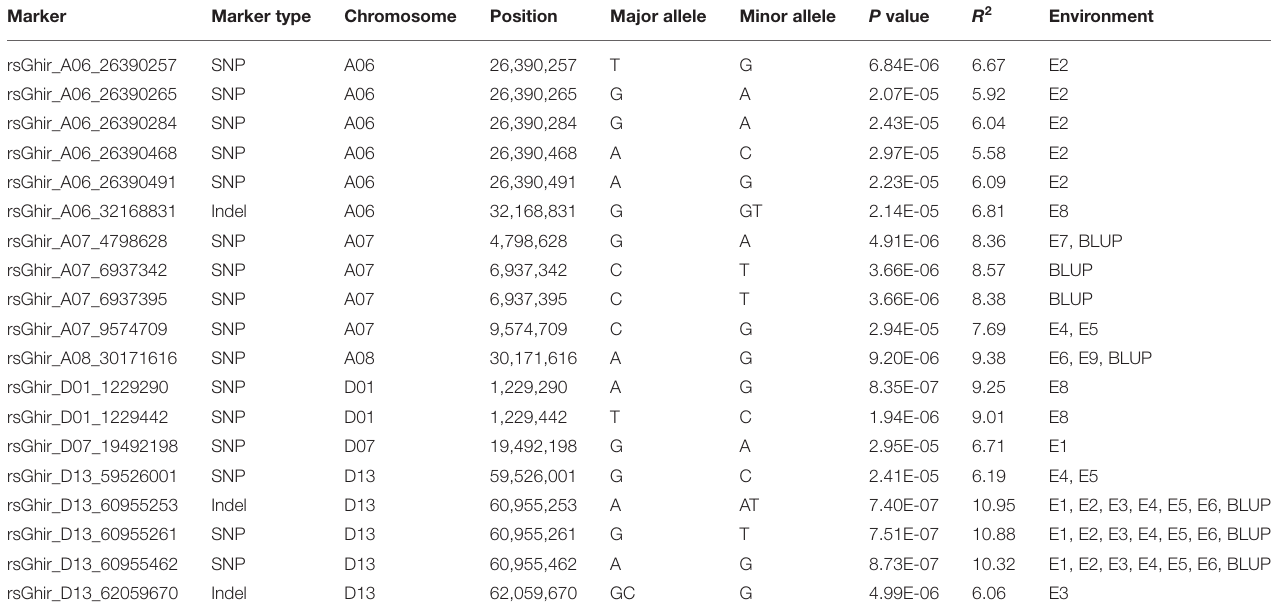
TABLE 2 | List of significant markers (SNPs and InDels) associated with boll weight. Marker Marker type Chromosome Position Major allele Minor allele P value R 2